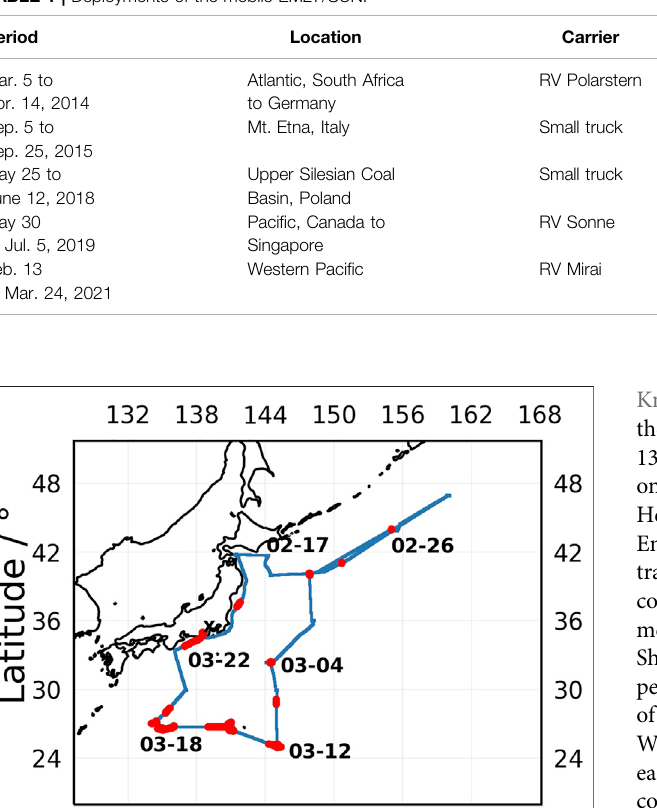
TABLE 1 | Deployments of the mobile EM27/SUN.